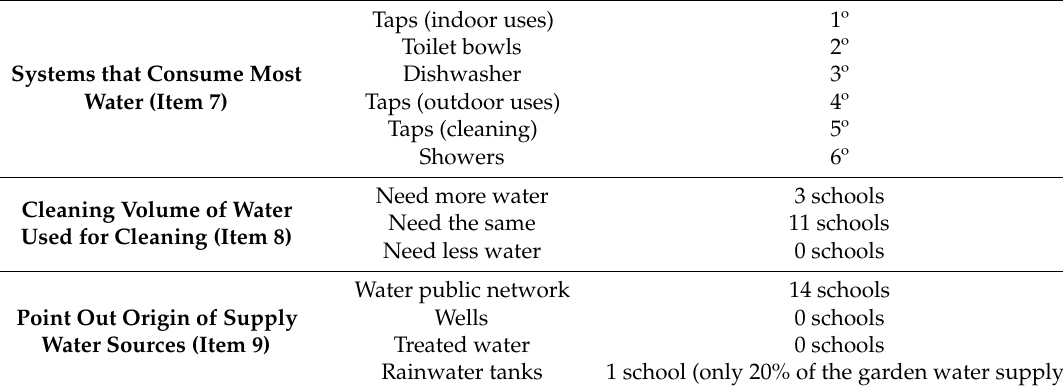
Figure 4. Water use in schools (%). Source: survey results. Own elaboration. Table 5. Uses and water management in